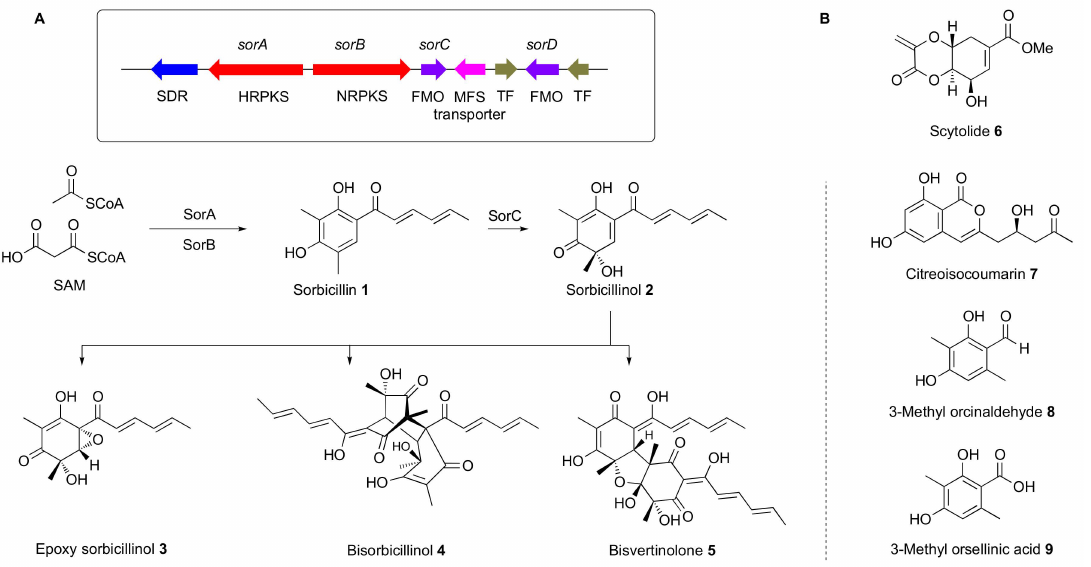
Figure 1. ( A ), the sorbicillin ( sor ) biosynthetic gene cluster in T. reesei , and known pathway to monomeric ( 1 – 3 ) and dimeric ( 4 – 5 ) sorbicillinoids; ( B ), compounds isolated from T. reesei QM6a · ∆ tmus53 · ∆ pyr4 · ∆ sorBC and T. reesei QM6a · ∆ tmus53 · ∆ sorBC · P pdc · aspks1